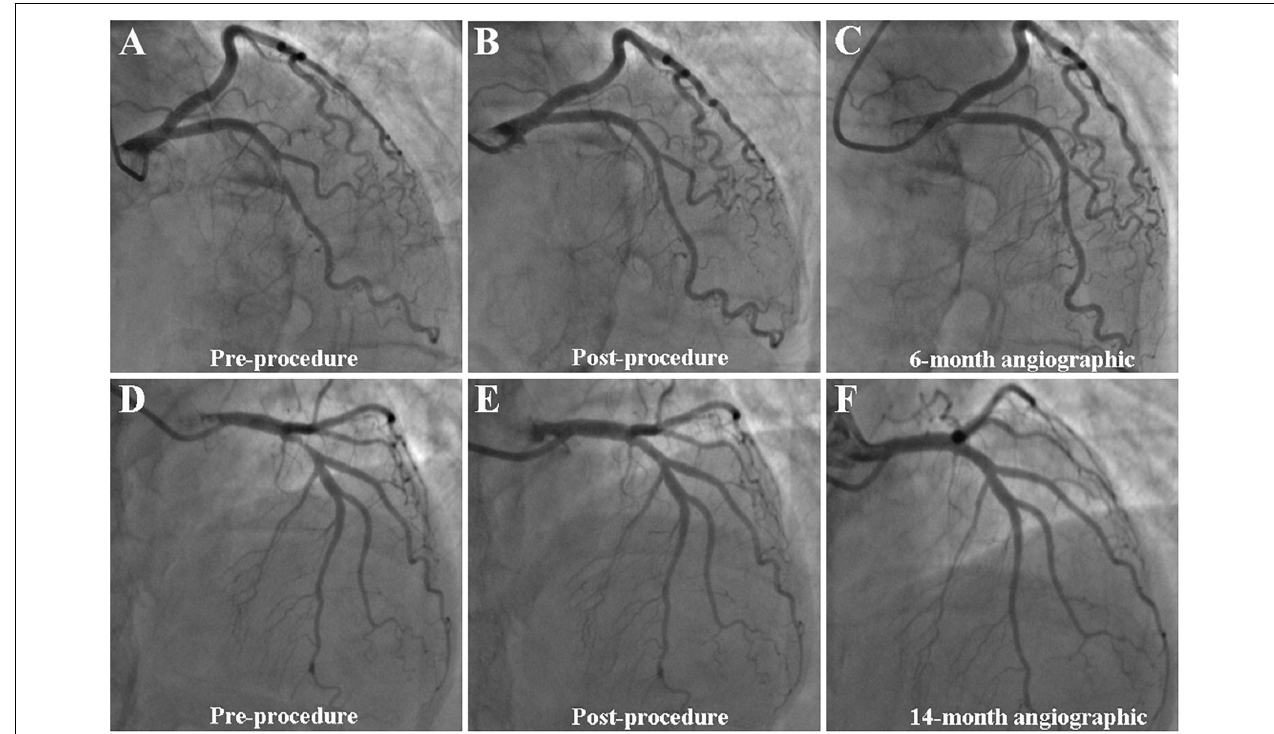
FIGURE 2 | Case example of DCB-only strategy for bifurcation (A–C) and non-bifurcation (D–F) . (A–C) A case example of DCB-only strategy for bifurcation. (A) Initial angiogram with LAD 90% visual stenosis; (B) final result with 10% residual stenosis after DCB treatment; and (C) 6-month follow-up angiography showed no obvious stenosis. (D–F) A case example of DCB-only strategy for non-bifurcation. (D) Initial angiogram with LAD 90% visual stenosis; (E) final result with 20% residual stenosis after DCB treatment; and (F) 14-month follow-up angiography showed no obvious